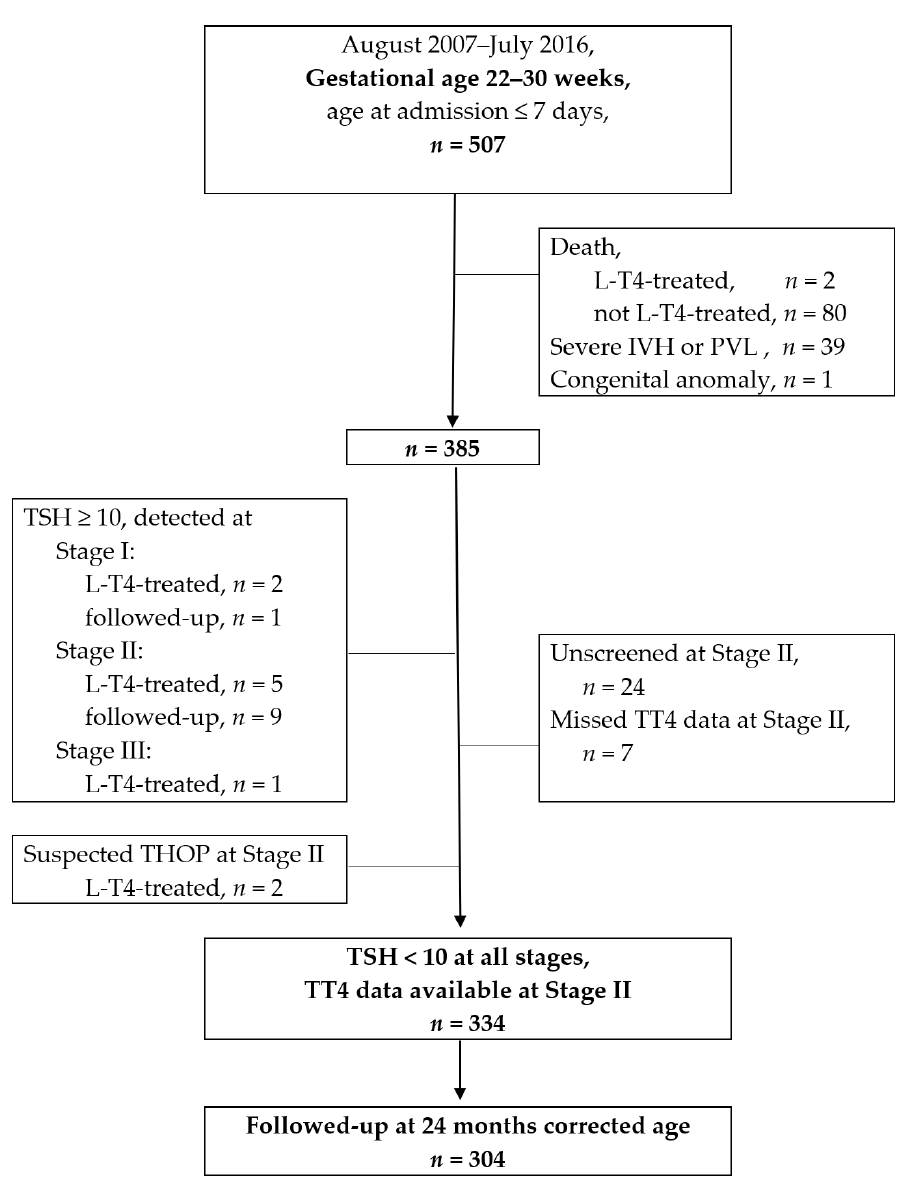
Figure 1. Flow chart of patient enrollments. L-T4: levothyroxine; IVH: intraventricular hemorrhage; PVL: periventricular leukomalacia; TSH: thyroid-stimulating hormone (unit: µ IU/mL); TT4: total serum thyroxin; THOP: transient hypothyroidism of prematurity; a detailed description of the stages presented in the methodology, Section 2.2.